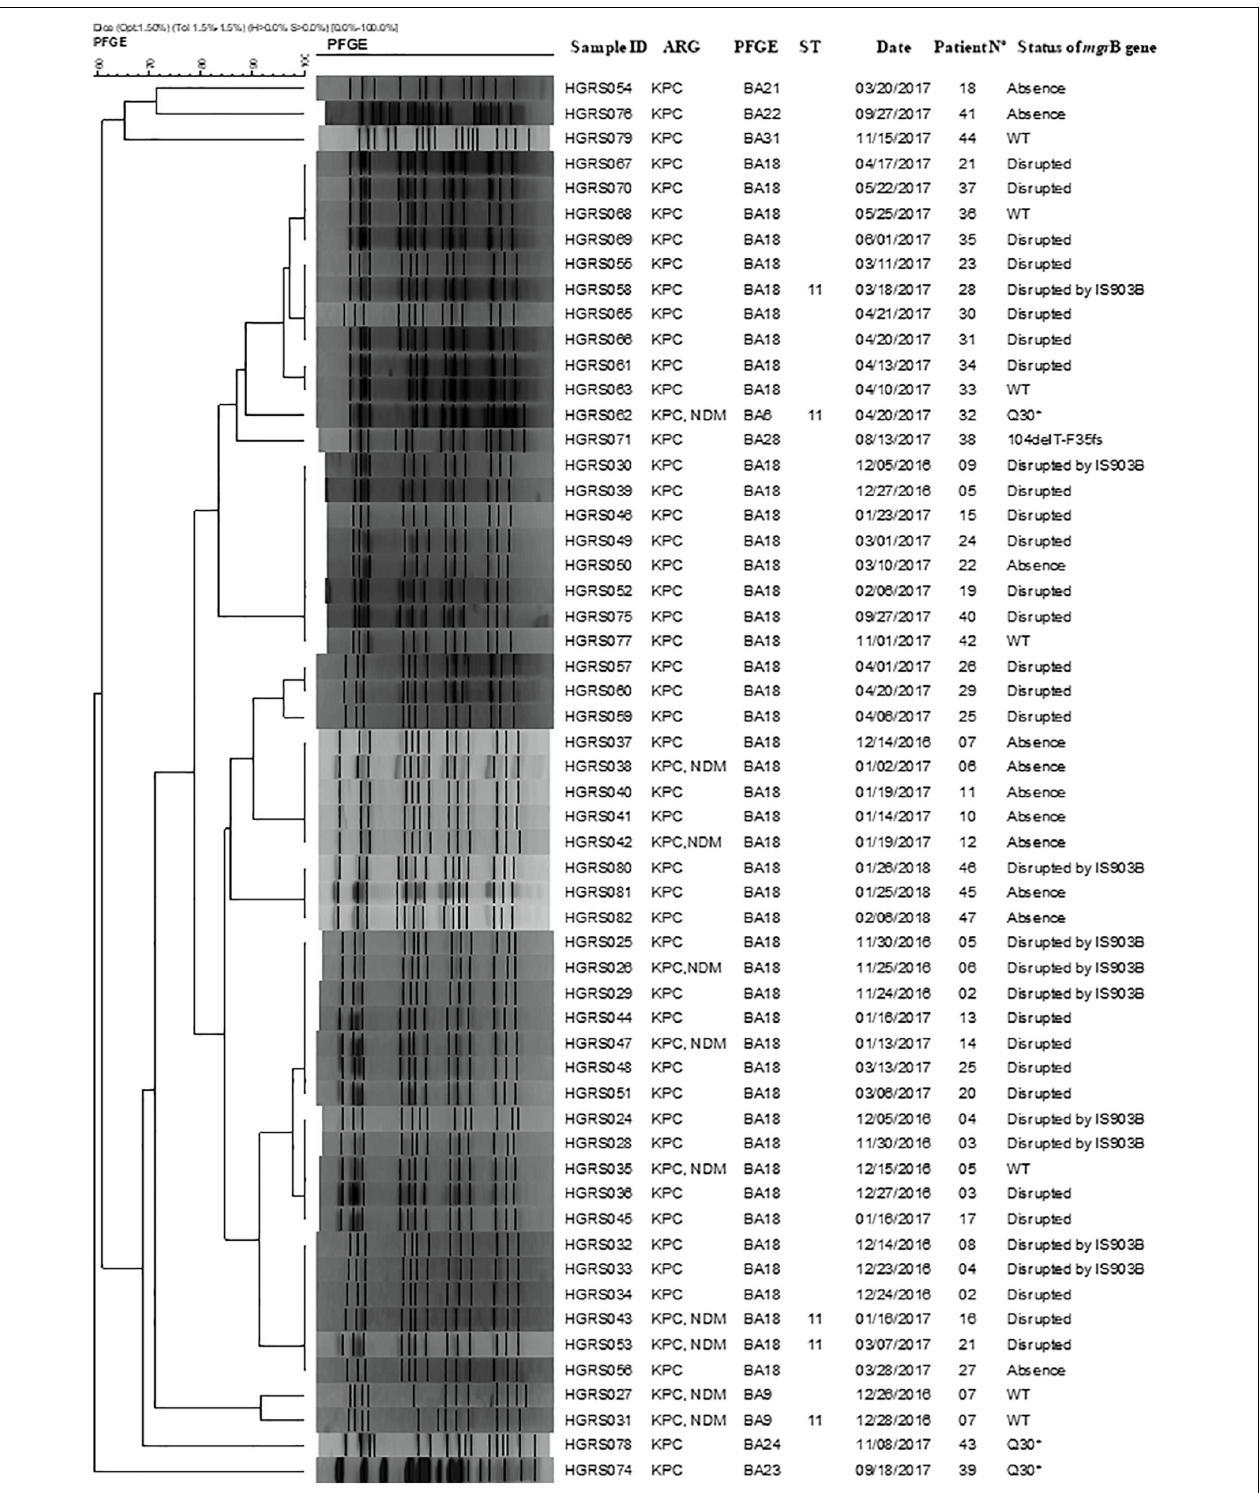
FIGURE 3 | Dendrogram showing the relatedness of ColR-CRKP based on PFGE patterns after digestion with Xba I. Isolates showing 80% similarity are considered related. ARG, Antimicrobial Resistance Genes; ID, identification; KPC, Klebsiella pneumoniae carbapenemase; NDM, New Delhi metallo-beta-lactamase; PFGE, Pulsed-field electrophoresis technique; ST, sequence typing; WT, Wild type; fs, Frameshift.